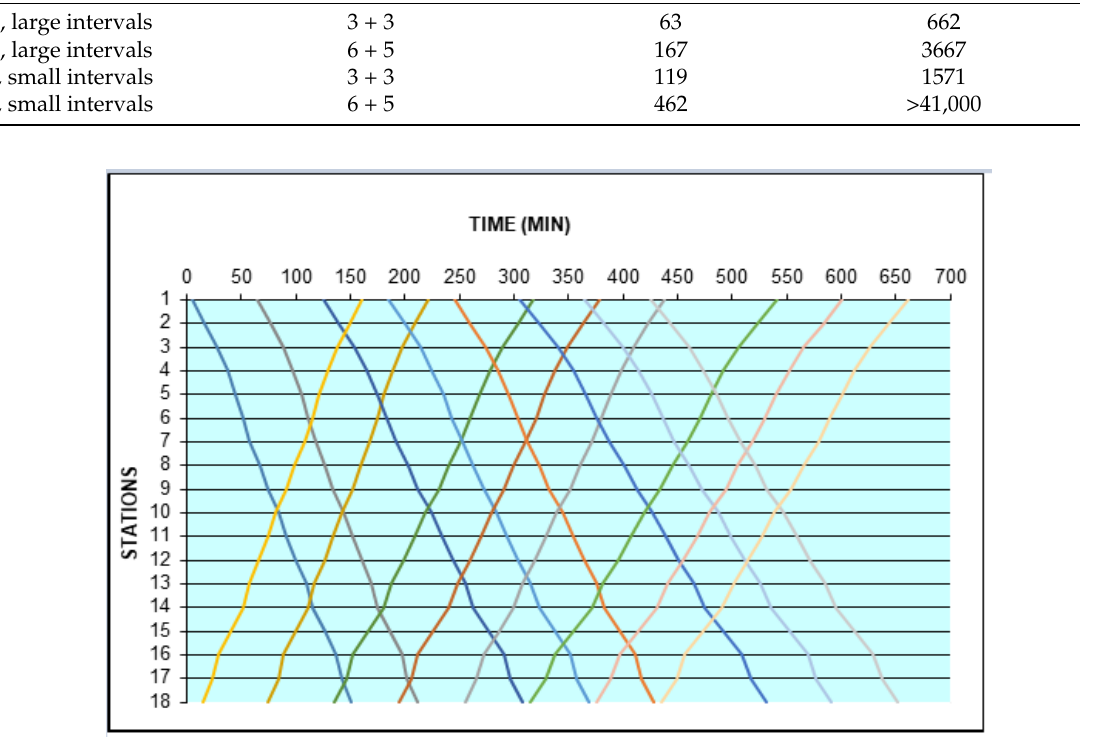
Figure 3. Unsolved state (infeasible schedule) of special 8 + 8 instance.